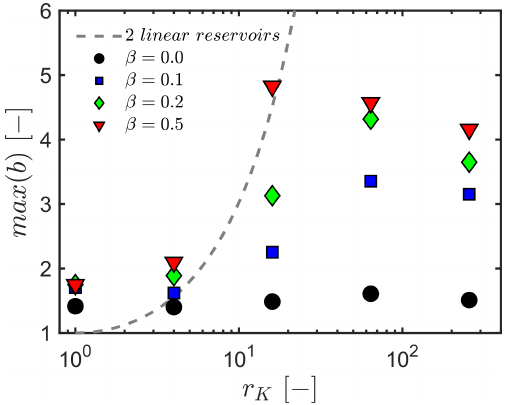
Figure 6. Maximum values of b as a function of r K . The different slope angles of the interface β are pictured by different symbols. The grey dashed line represents the Gao et al. (2017) model, pre- dicting the evolution of maximum values of b as a function of r K , considering the drainage of two linear reservoirs in